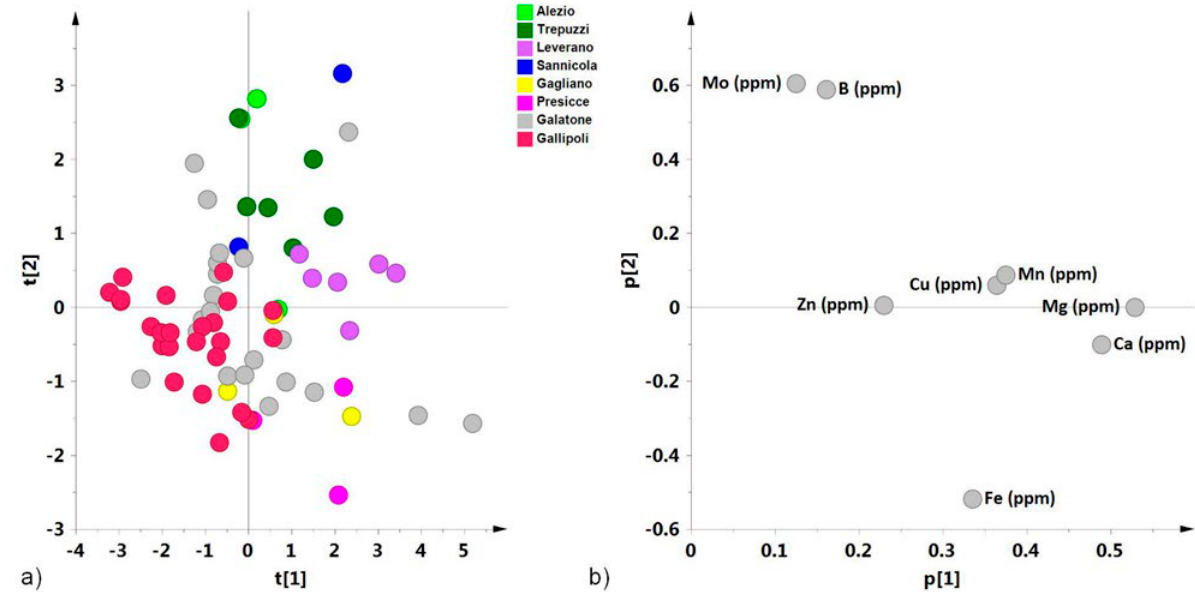
Figure 2. Principal component analysis for leaf samples collected from different sites in the Salento area (Southern Apulia). t[1]/t[2] score- plot (a) and corresponding p[1]/p[2] loadings plot (b). Two principal components (t[1]/t[2]) explained about 55% of total variance (R 2 = 0.39 for t[1] and 0.21 for t[2]), with a predictability value of Q 2 =